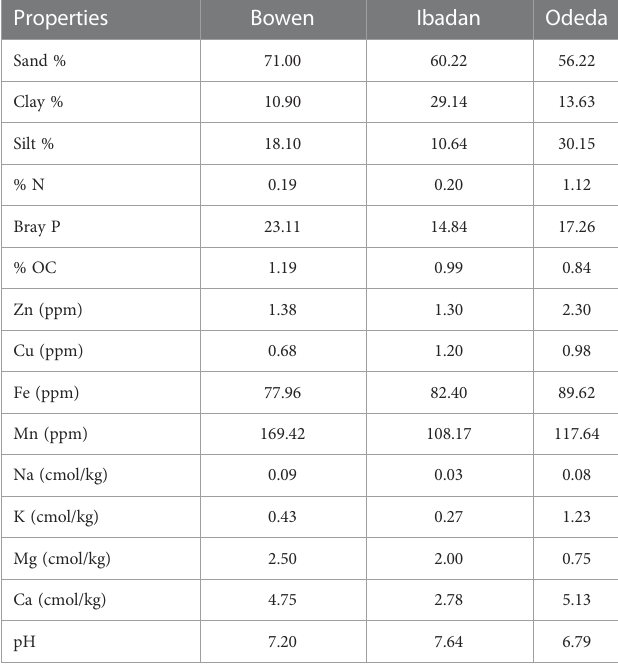
TABLE 3 Physio-chemical composition of soil from Bowen, Ibadan, and Odeda.